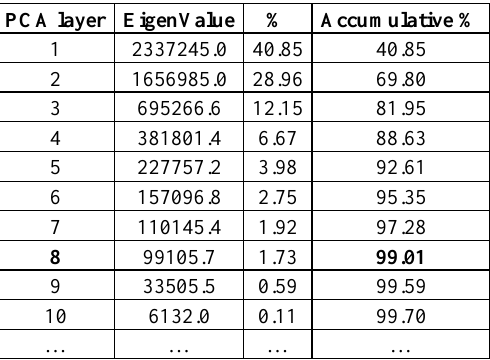
Table 3. Principal Component Analysis: percent and